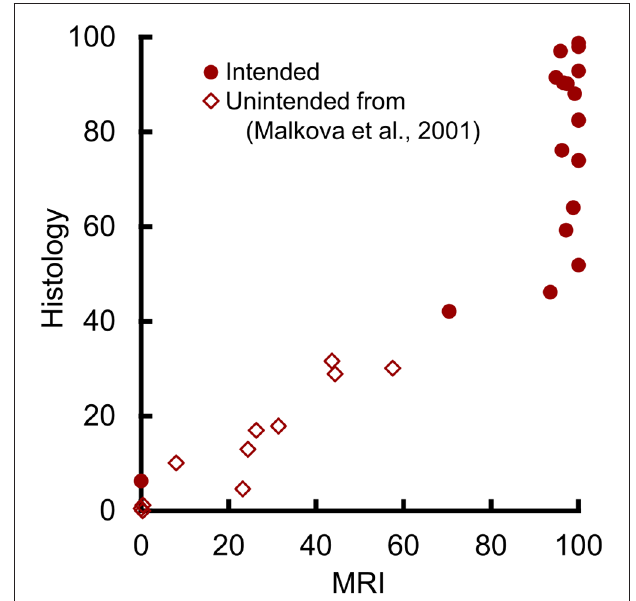
FIGURE 4 | MRI hypersignal predicted amygdala damage in the 0%–50% range. Percent of amygdala damage as estimated by T2 MRI and by histological examination. Each dot represents one hemisphere. Solid circles ( n = 19) represent intended damage in the current study, and open diamonds ( n = 11) represent unintended damage from the hemispheres reported by Málková et al. (2001).